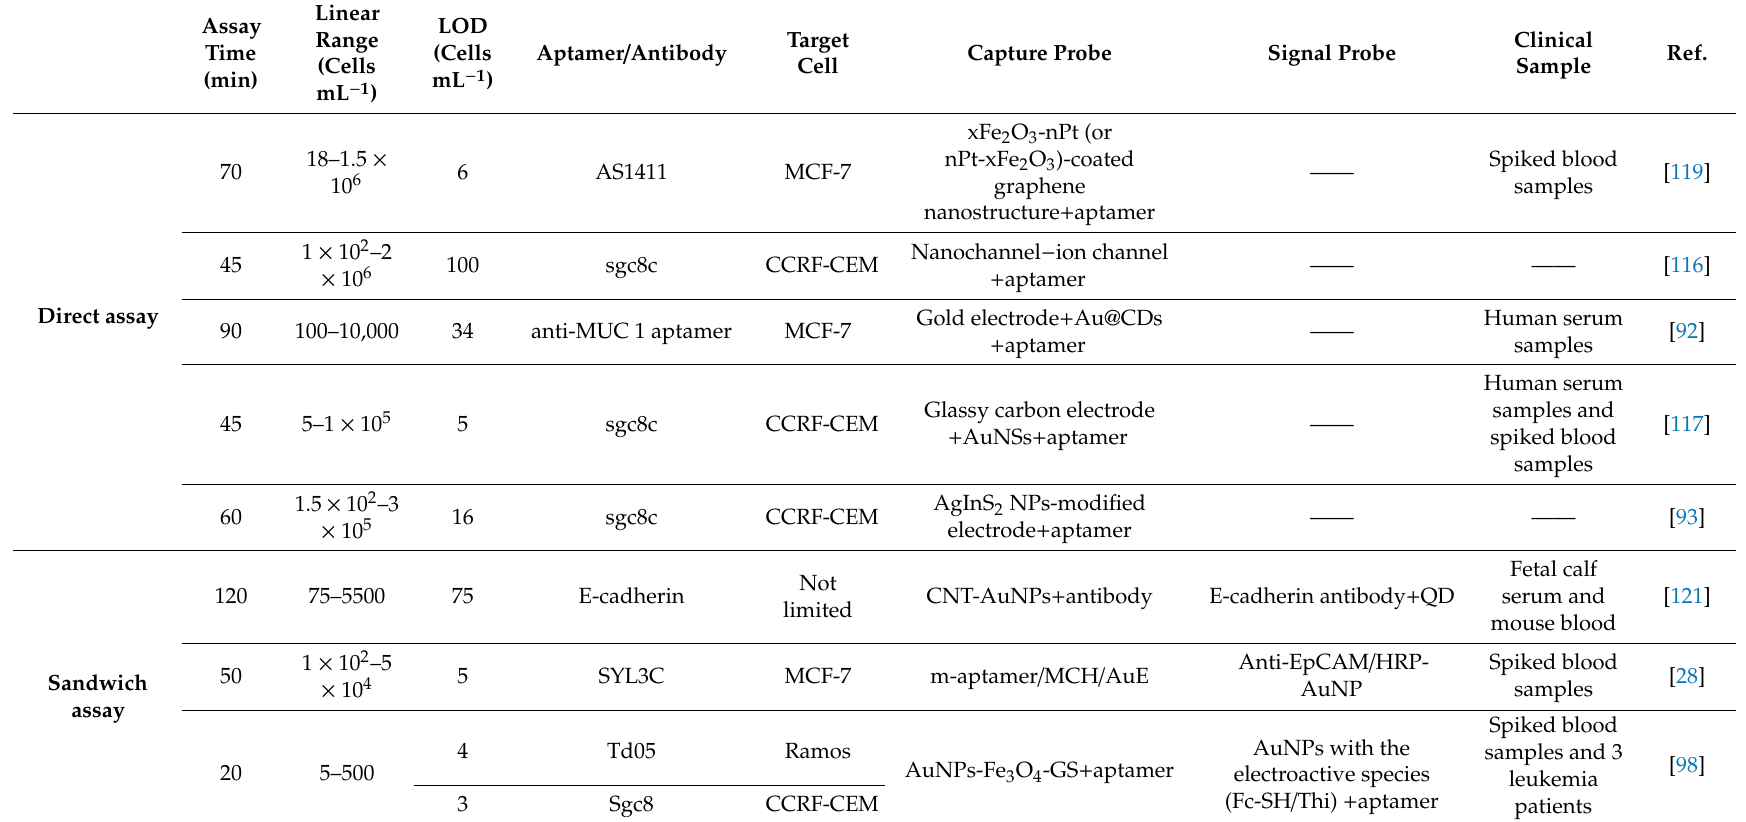
Table 3. Summary of electrochemical CTC detection